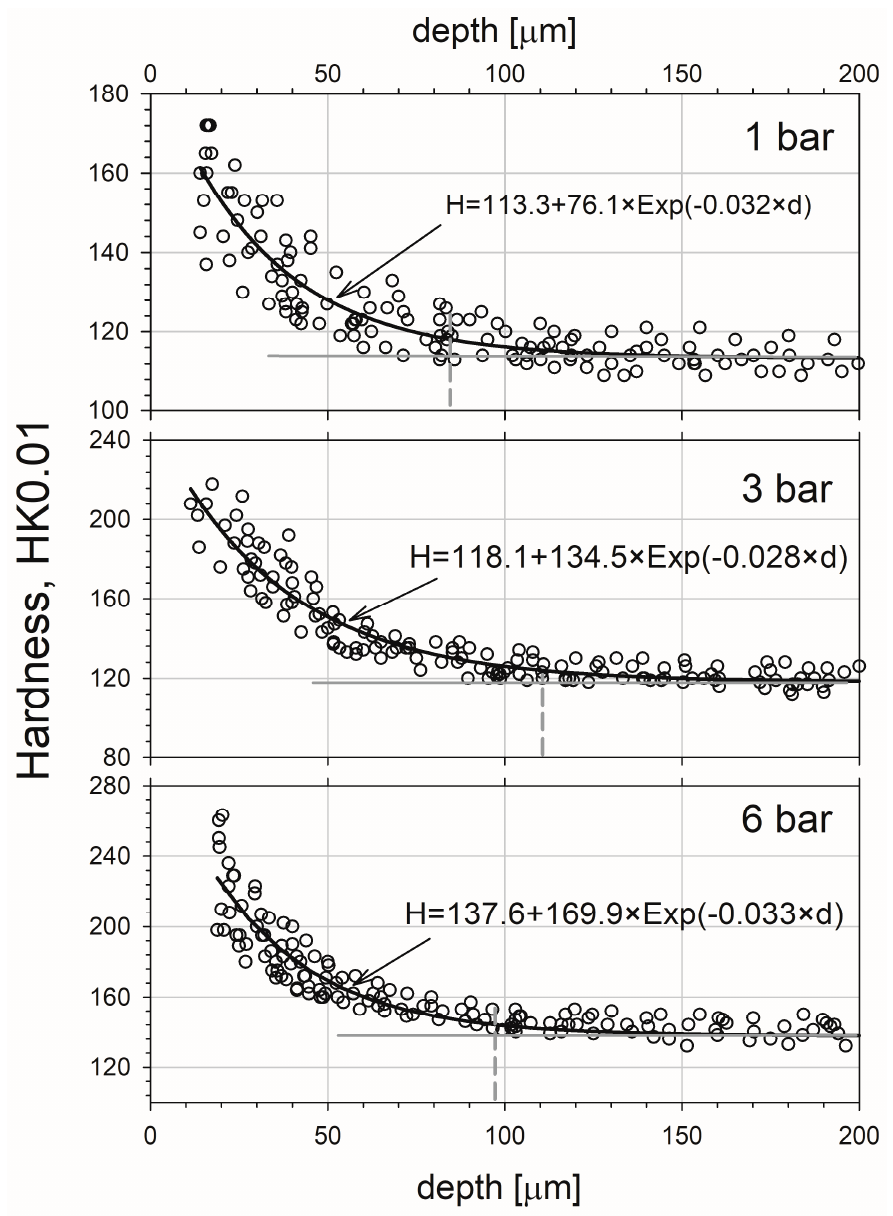
Figure 10. The depth profile of microhardness of the studied copper samples exposed to sandblasting at various pressures. The black solid lines represent the best fits of the exponential decay functions to the experimental points. The dashed vertical lines tag the depth of the workhardening zone for each sample. The error in the hardness measurement can be roughly estimated as ca. 20 HK for sample blasted at 1 bar and ca. 40 HK for those blasted at 3 and 6 bar.